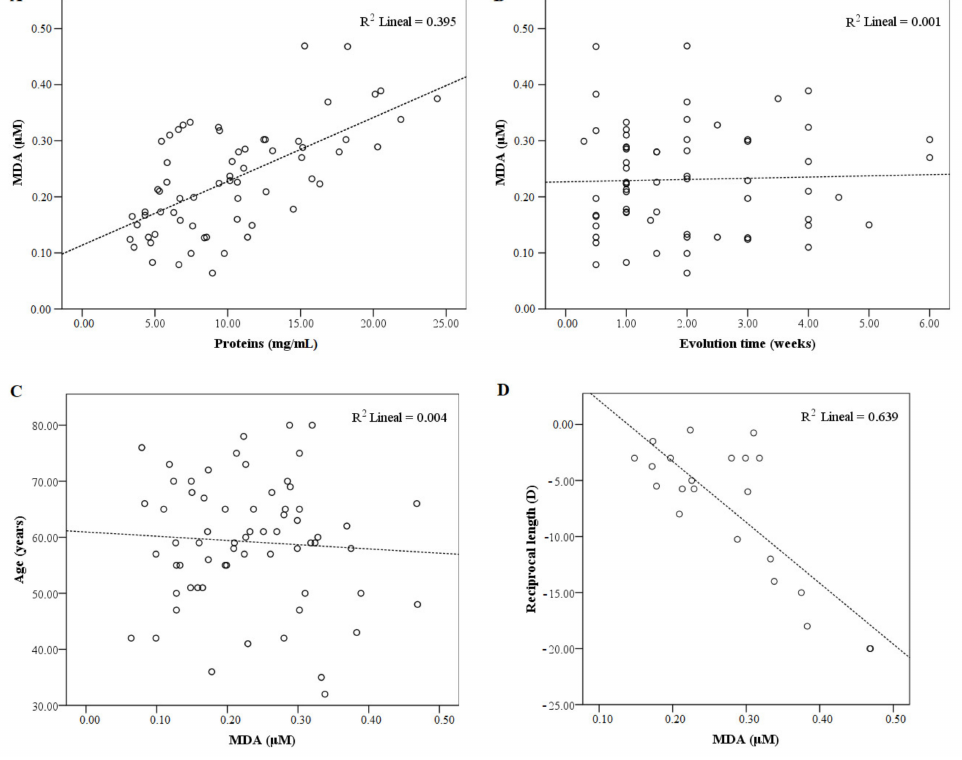
Figure 1. Correlations between the malondialdehyde (MDA) and the main studied parameters. The scatter plot showing Pearson’s correlation between: ( A ) MDA and protein concentration, r = 0.629, p < 0.001, and n = 65; ( B ) MDA and retinal detachment evolution time, r = 0.032, p = 0.800, and n = 65; ( C ) MDA and patients’ age, r = − 0.064, p = 0.612, and n = 65; and ( D ) MDA and degree of myopia, r = − 0.800, p < 0.001, and n =